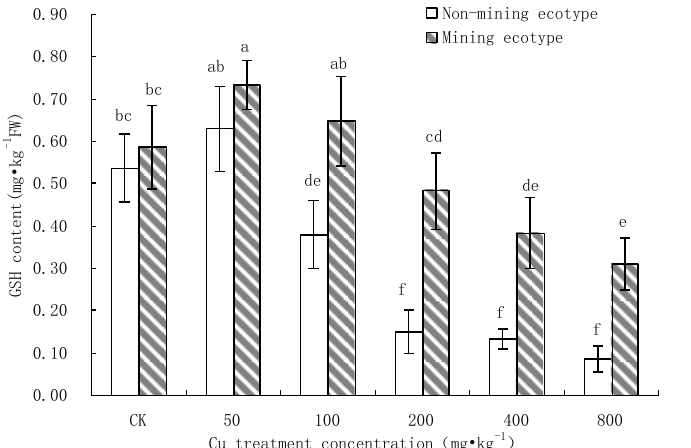
Figure 5. GSH concentrations of two ecotypes of M. floridulus under different Cu treatment. Note: Error bars indicate standard deviation; Different letters in the same group indicate significant difference at p < 0.05 according to Duncan’s multiple range tests; the same below.